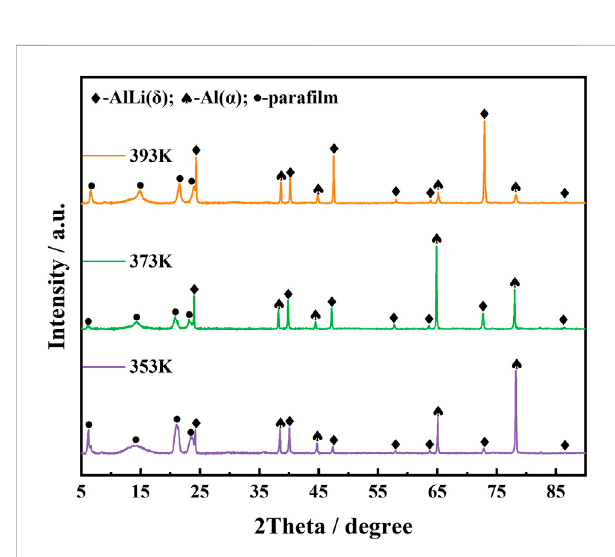
XRD patterns of Al-Li alloy samples obtained by electrodeposition at − 0.5 V al for 1 h at various temperatures (353 K, 373 K, 393